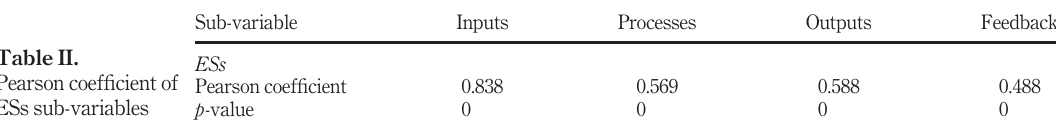
of the research indicators